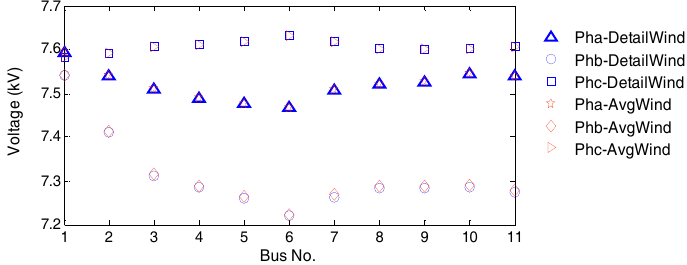
Figure 15. Comparison of steady state Phase voltages of busses with standard detailed and average models of DFIG when the microgrid is grid connected.